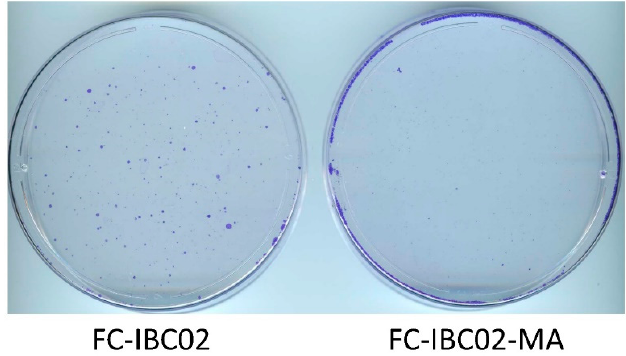
Figure 5. Inhibition of the growth of FC-IBC02 and FC-IBC02-MA cells by treatment with JIB-04. Cultures of both cell lines were treated in parallel with 62.5 nM JIB-04 for 14 days and then stained with crystal violet. Based on a comparison of the number of colonies in the images, JIB-04 affected the FC-IBC02-MA cells much more severely than the parental FC-IBC02 cells.